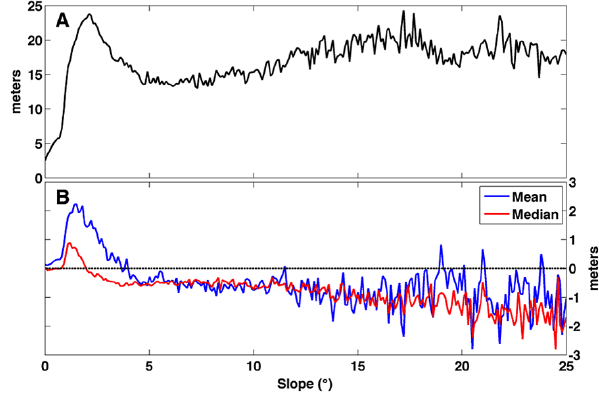
Figure 7. Plots of surface slope, in degrees from horizontal, versus the (a) GIMP DEM/ ICESat RMS validation error and (b) the (blue curve) mean and (red curve) median difference between the GIMP DEM and ICESat elevations.